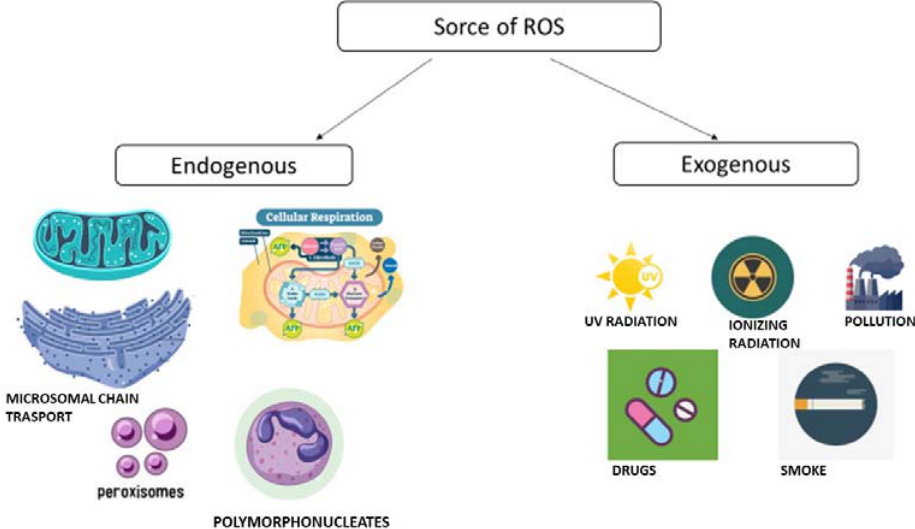
Figure 1. These are the main source of ROS (reactive oxygen